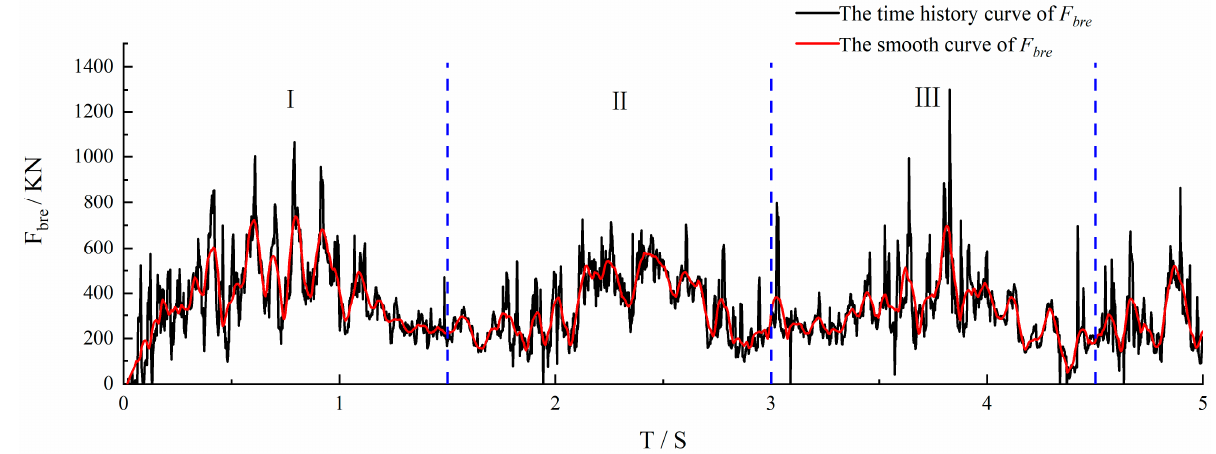
Figure 10. Icebreaking resistance curve.